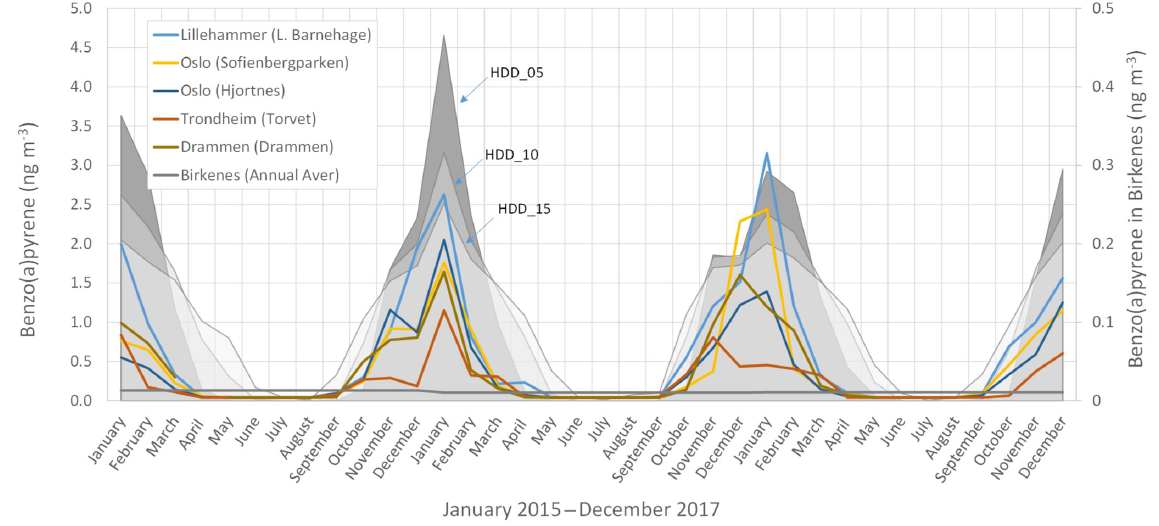
Figure 9. Monthly average Benzo(a)pyrene air concentrations at five urban sites in Norway along with the annually averaged concentration on Birkenes, a rural background station in the south of Norway. The shaded areas show the monthly RWC activity predicted by HDD with a temperature threshold of 5, 10 and 15 ◦